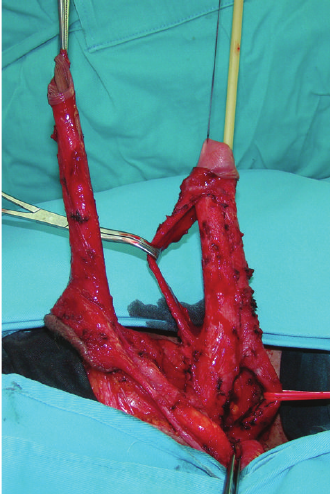
Figure 2: Freed penile skin, dissected neurovascular bundle and mobilized urethra.